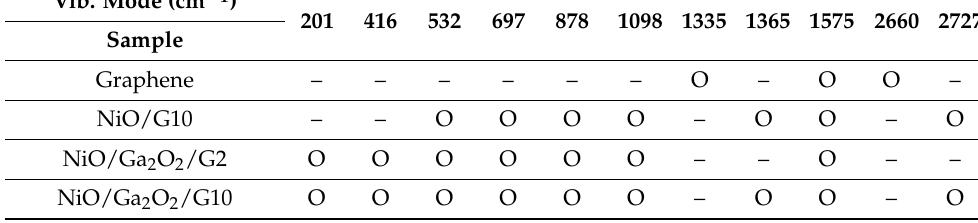
Table 2. Raman vibration modes observed for graphene, NiO/G10, NiO/Ga 2 O 2 /G2, and NiO/Ga 2 O 2 /G10